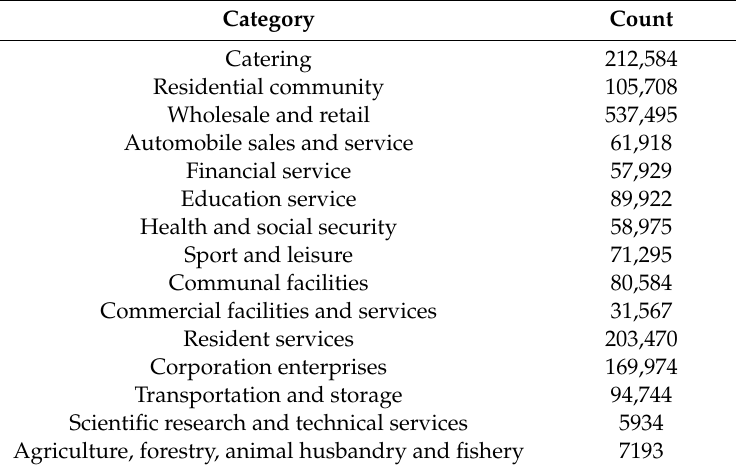
Table 2. The number of point-of-interests (POIs) in each of the 15